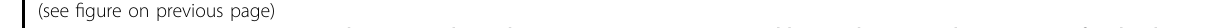
birinapant interfered with carboplatin DNA damage response. Subcutaneous xenografts were obtained after 1 week of in vivo treatment with simultaneous or sequential doses of birinapant and chemotherapy, as described (schema in Fig. 3A). γ H2A.X staining indicative